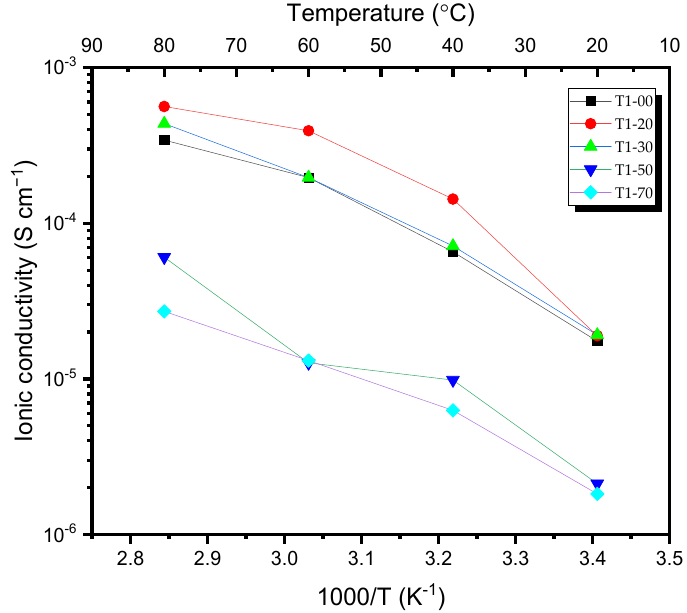
Figure 5. Temperature-dependent ionic conductivities of T1 series SPE membranes.